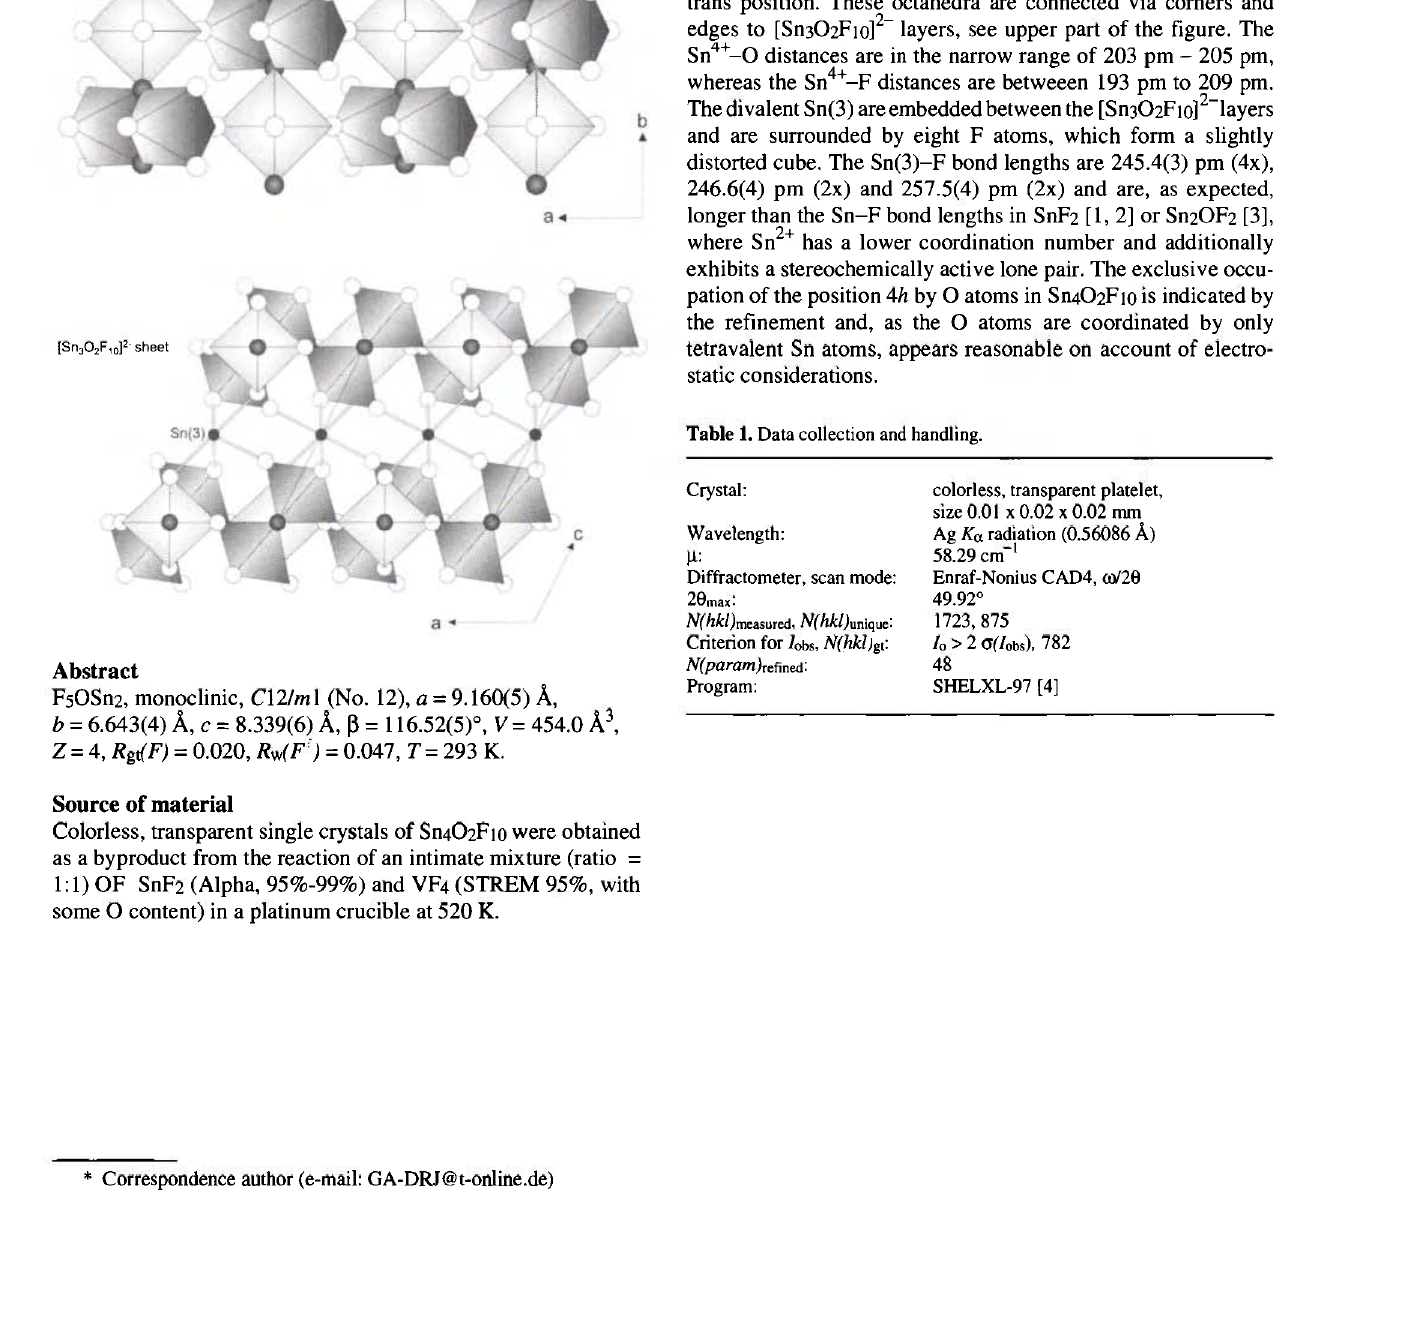
Source of material